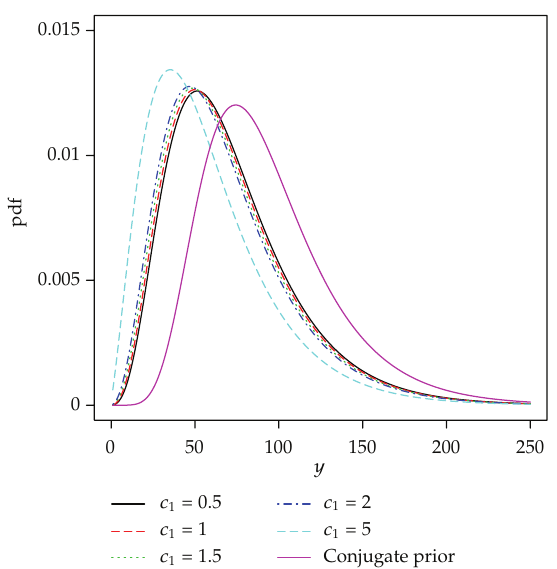
Figure 6: Estimate of the predictive distribution for the given data set for extended Je ff reys’ prior and conjugate